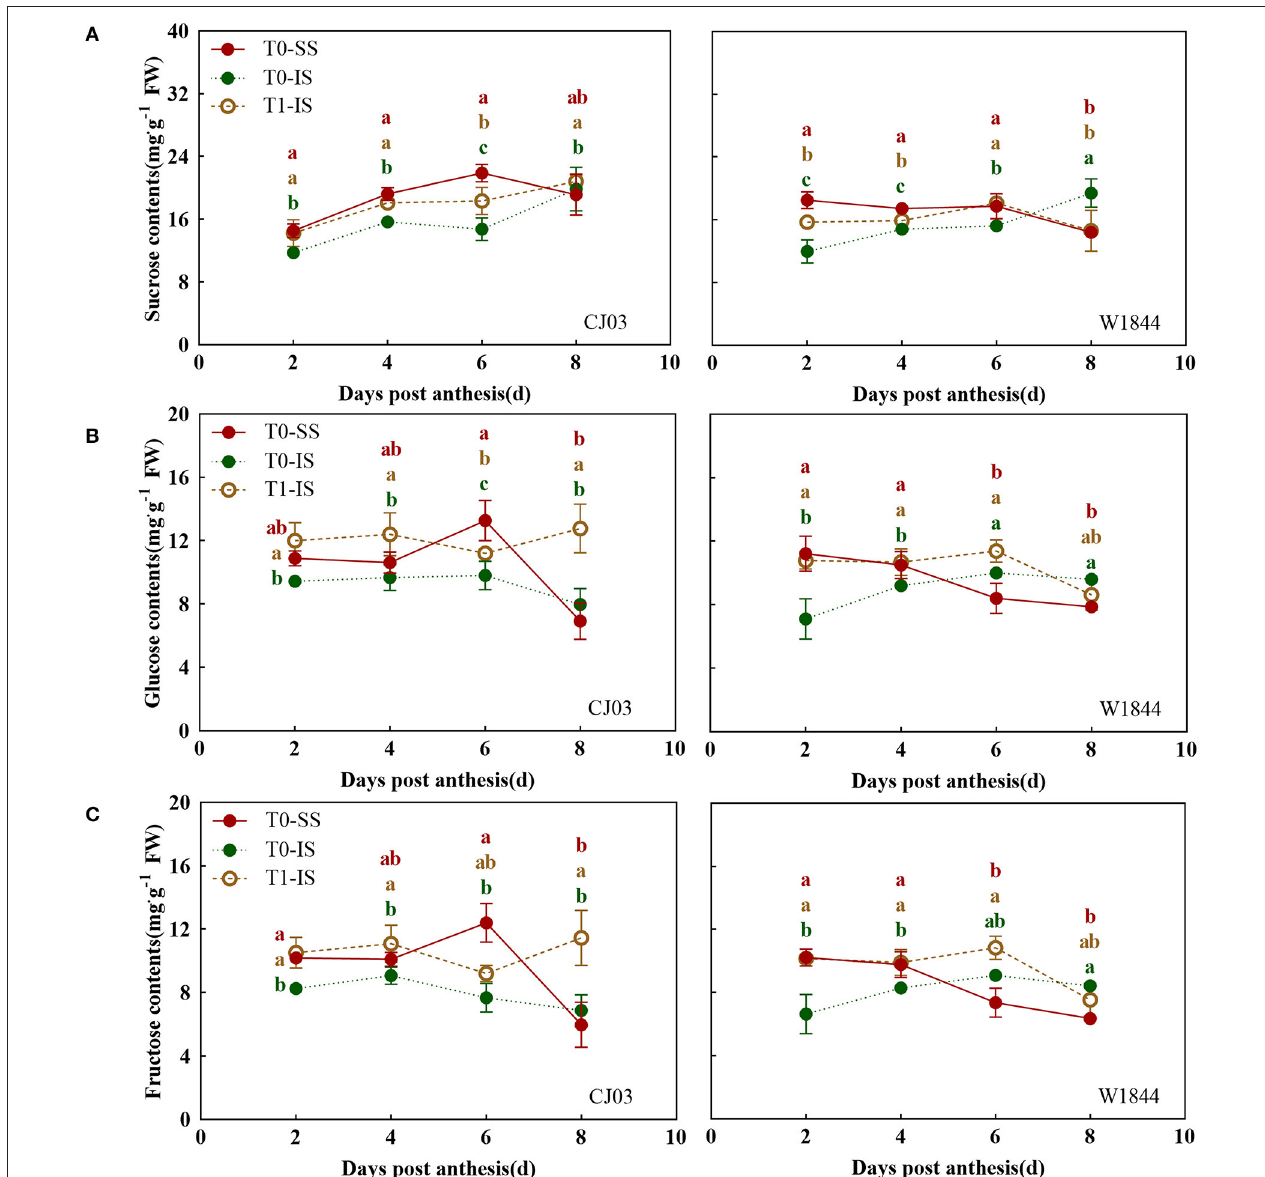
FIGURE 5 | Changes of soluble carbohydrates contents in developing grains of CJ03 and W1844. The T0-control group without any treatment; T1- top 2/3 of the spikelet were removed. Sucrose (A) , Glucose (B) ; and Fructose (C) in developing grains of test materials. Colored letters indicate statistically significant differences at the P = 0.05